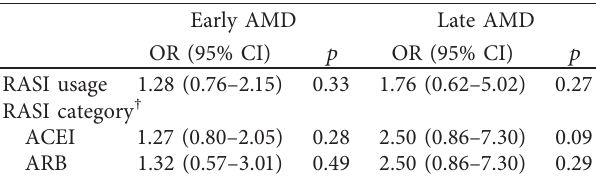
Table 3: Multivariate-adjusted ORs for AMD among the hyper- tensive